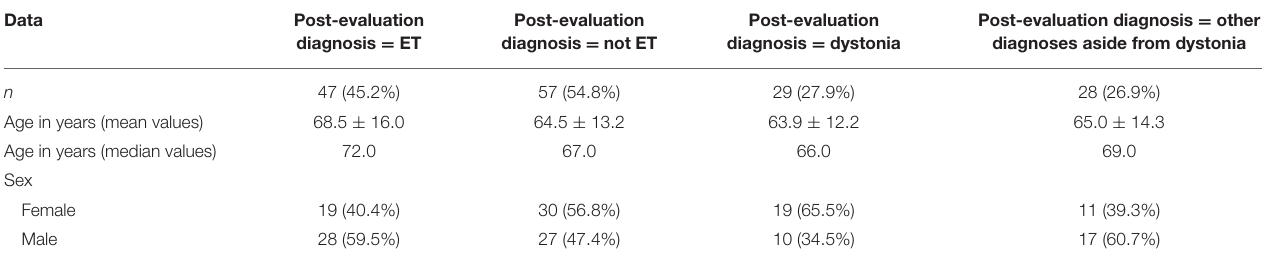
TABLE 2 | Demographic data on 104 patients.